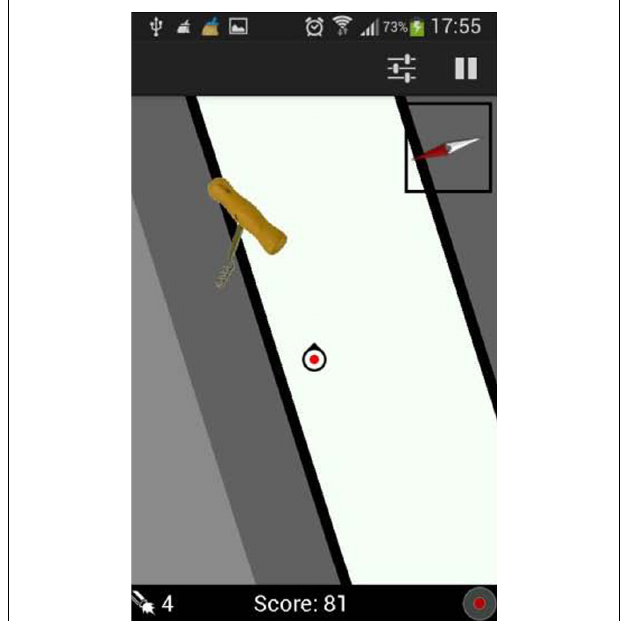
FIGURE 2 | Screenshot from the geoshooter application used in the hybrid condition.